Question: Give a one-sentence summary of this figure.
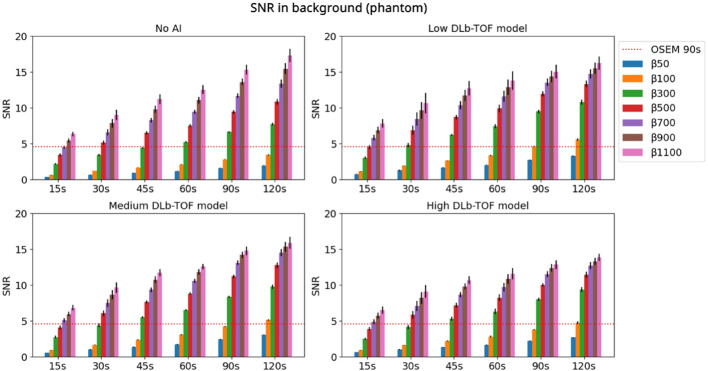
Answer: Signal-to-noise (SNR) from a homogeneous background in an anthropomorphic phantom, as a function of acquisition time and β-value without (No AI) and with the three levels of DLb-TOF model (Low, Medium and High). The dotted line represents SNR for 90 s acquisition time reconstructed with OSEM. Error bars indicate ± 1 SD